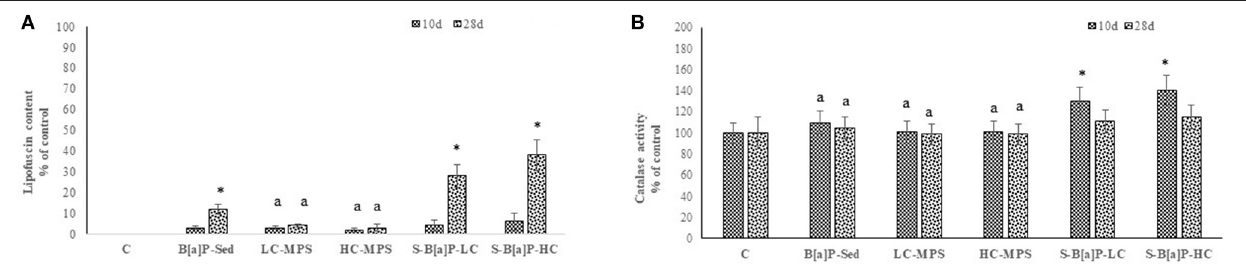
FIGURE 3 | Biological responses in tissues of H. diversicolor exposed to uncontaminated sediments (C), D sediments spiked with 1 mg/L B[a]P (S-B[a]P), sediments spiked with 200 and 2000 particles/kg virgin PVC (LC-MPS, HC-MPS) and sediments with B[a]P spiked microplastic particles (B[a]P-LC: 200 particles/kg.; B[a]P-HC: